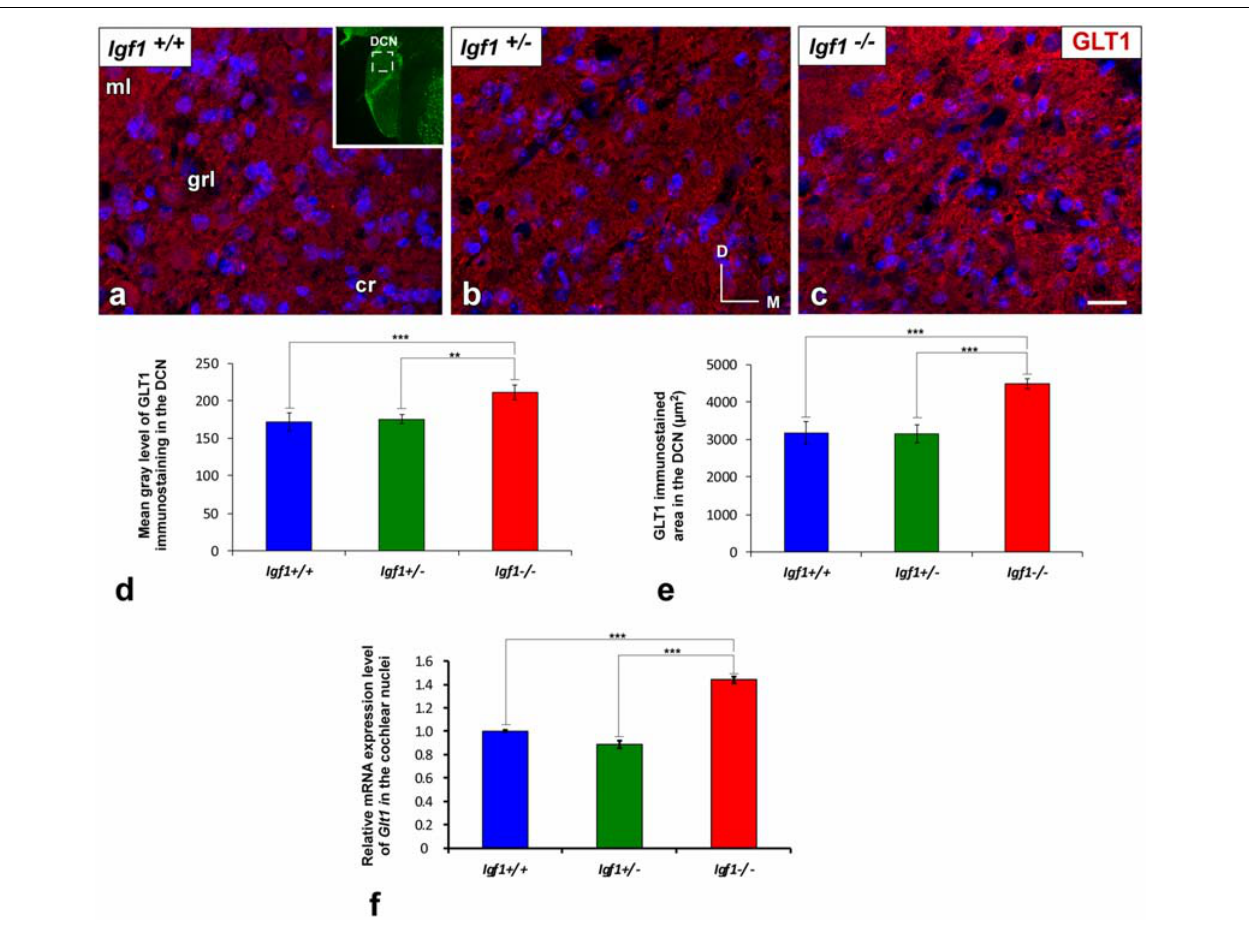
FIGURE 7 | Upregulation of GLT1 in the DCN of Igf1 − / − mice. In the Igf1 − / − mouse, the strongly GLT1 immunostained puncta (red) were found in all layers of the nucleus and presumptively occupied a larger area (C) than in the other genotypes (A,B) . These qualitative observations were corroborated by significant increases in the mean gray levels and the immunostained areas (D,E) . Similar increases in the IGF-1 deficient DCN were also detected by quantifying Glt1 mRNA expression (F) . The inset in ( A ; pseudo-colored green for higher contrast) indicates the approximate location of the fields shown in (A–C) . Error bars indicate the standard deviations of the mean. Statistically significant differences among the animal groups were evaluated by one-factor ANOVA ( ∗∗ p < 0.01, ∗∗∗ p < 0.001). Cell nuclei are stained with DAPI (blue). Abbreviations: cr, central region of the dorsal cochlear nucleus (DCN); GLT1, glutamate transporter 1; grl, granule/fusiform layer; ml, molecular layer. Scale bar: 20 µ m in ( C ; it also applies to A , B